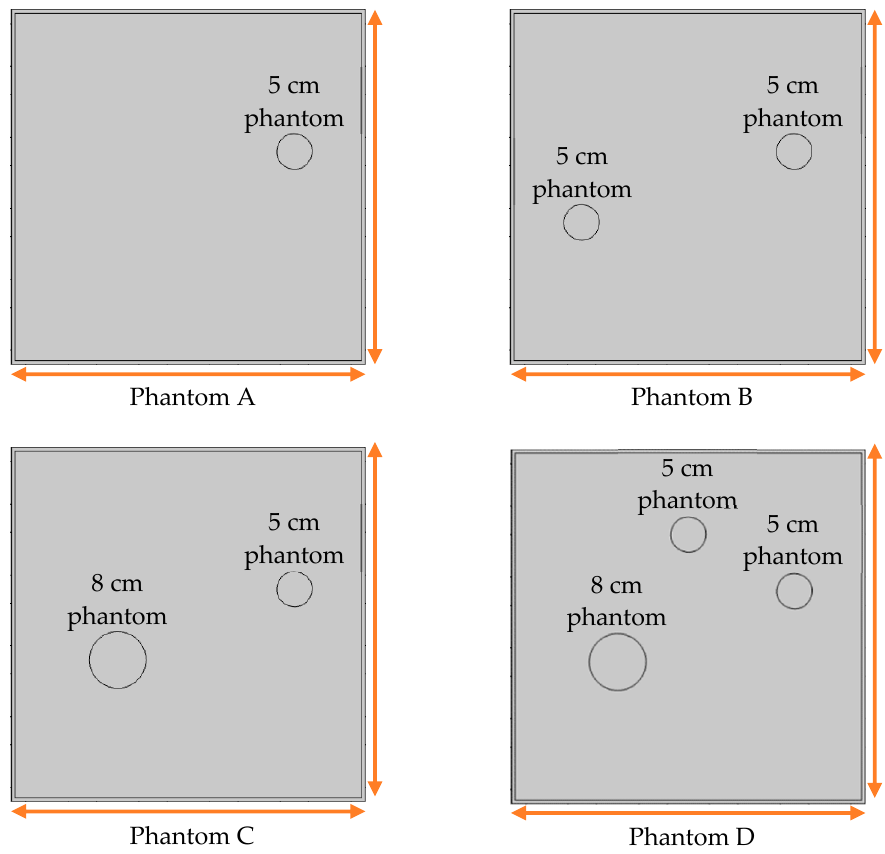
Figure 4. Simulation of rice phantom (moisture distribution).